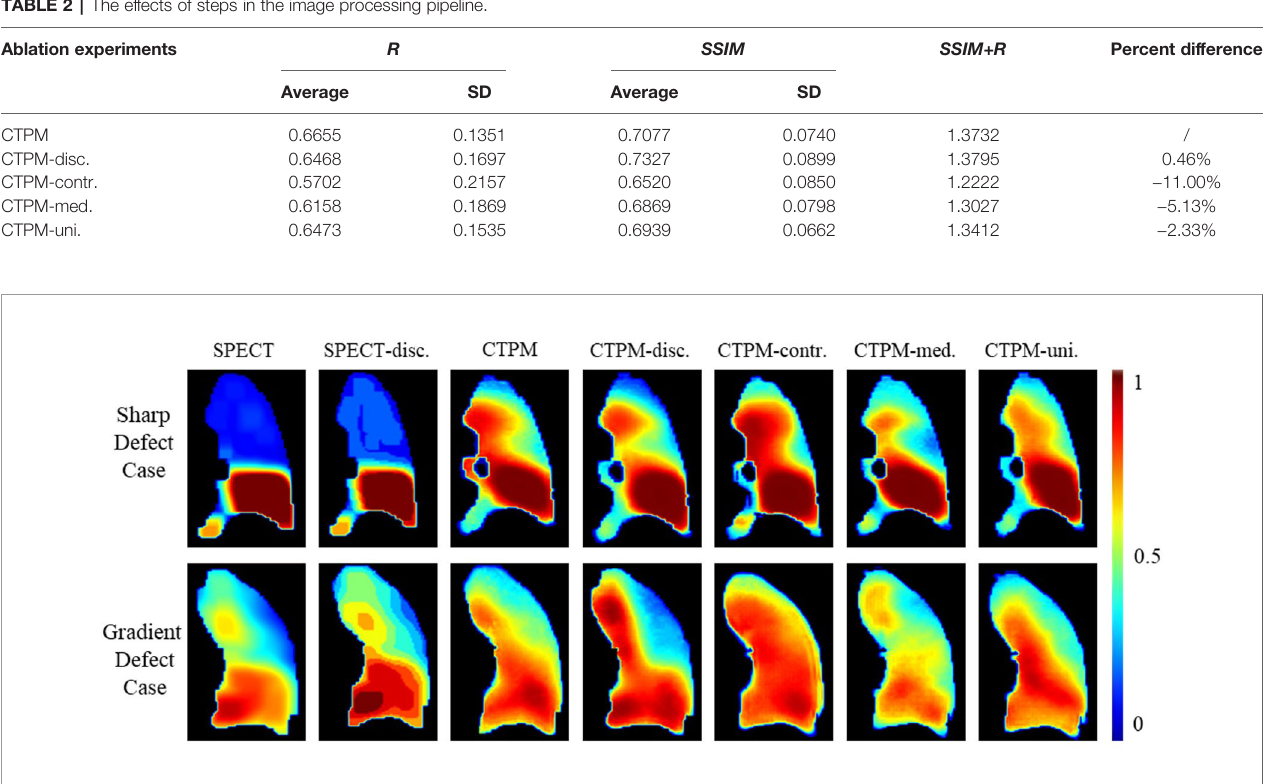
FIGURE 3 | Illustration of the effects of different image processing steps in coronal view. Two representative cases with the sharp low functional and gradient low functional were visualized for comparison. The SPECT perfusion was normalized using the approach described in the method section. The color means the perfusion level. SPECT-disc. was the discretized label. CTPM was generated using the proposed setting. The following CTPMs were generated with fi ve ablation scenarios: disc. — remove label discretization; contr. — remove CT contrast enhancement; med. — remove the median fi lter in CT low functional enhancement; uni. — remove the uniform fi lter in CT low functional